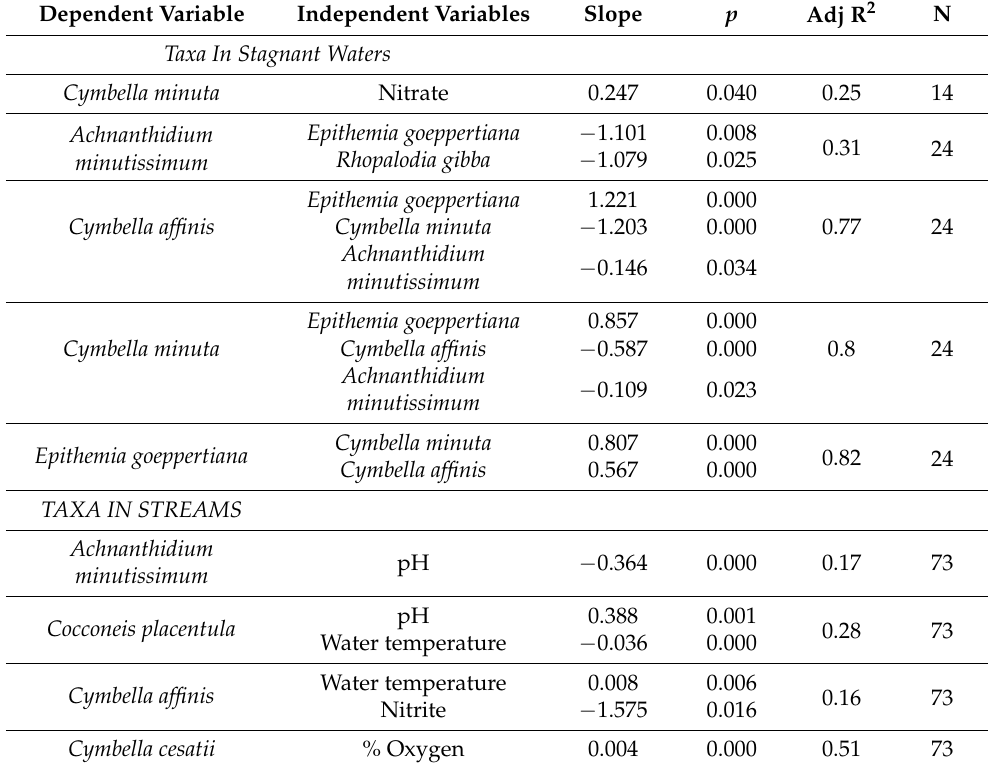
Table 4. Factors (environmental and diatom populations) related to the main taxa of benthic diatom taxa living in the water sites within the study area (Serran í a de Cuenca) during summer, as estimated through stepwise multiple regression ( p < 0.05). In each section, relationships with abiotic factors are mentioned first, followed by relationships between